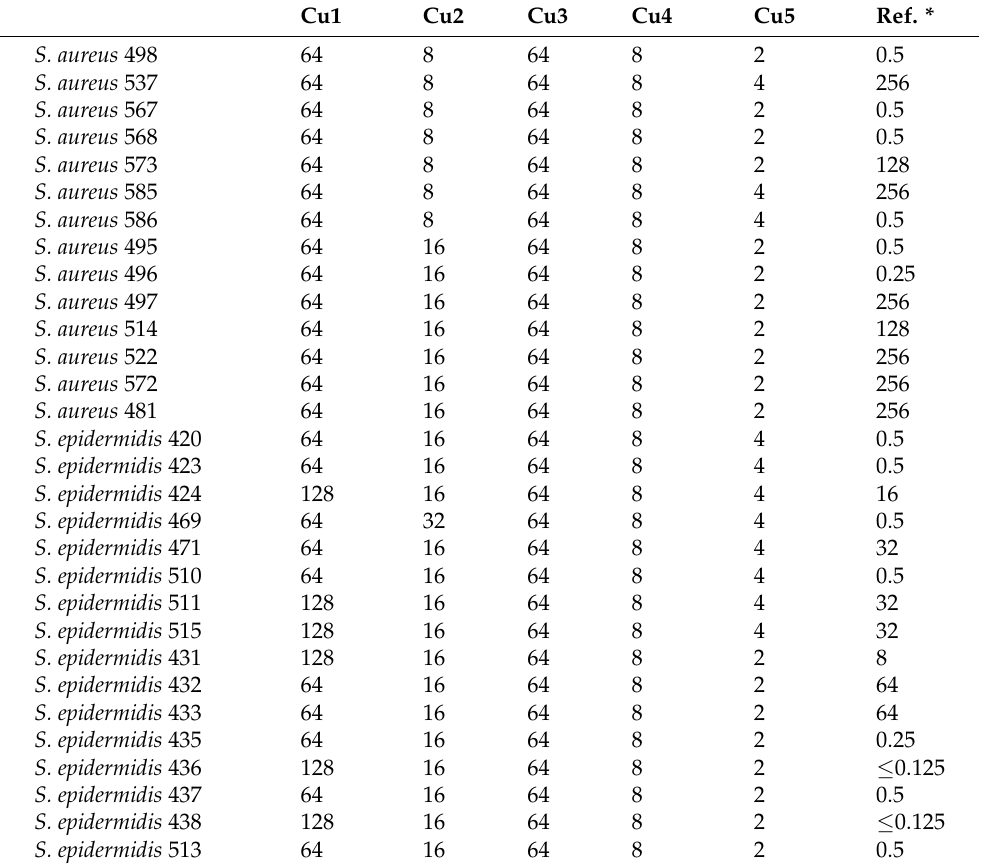
Table 5. In vitro activity of thiourea complexes Cu1 – Cu5 against hospital methicillin-resistant strains of Staphylococcus aureus (MRSA) and Staphylococcus epidermidis (MRSE)—minimal inhibitory concen- trations (MIC, µ g/mL). Ref.